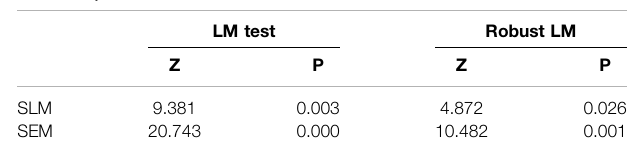
TABLE 2 | LM test and robust